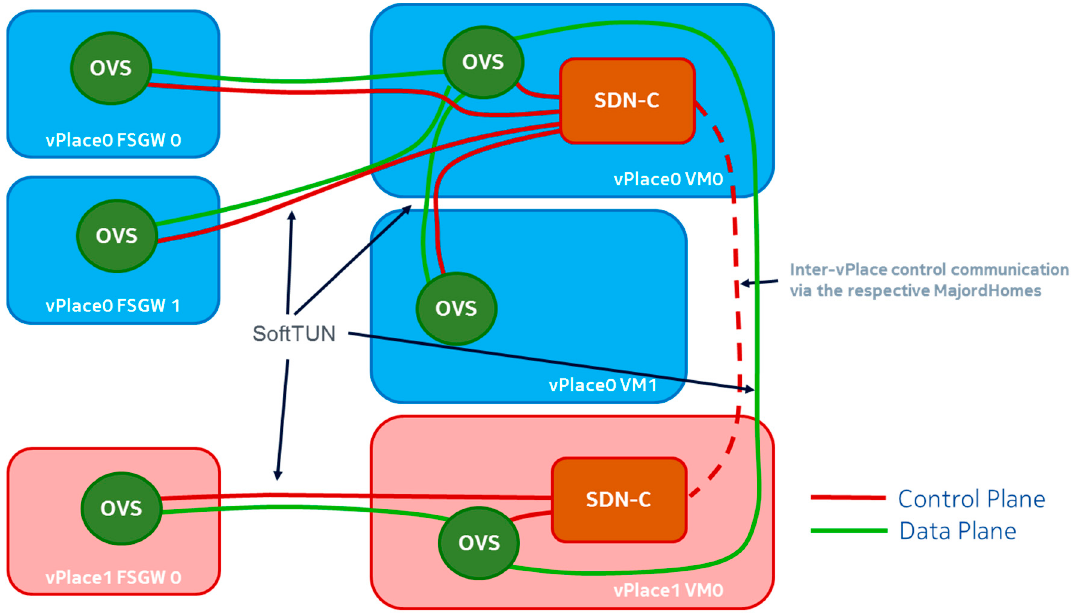
Figure 8. High-level SDN architecture.